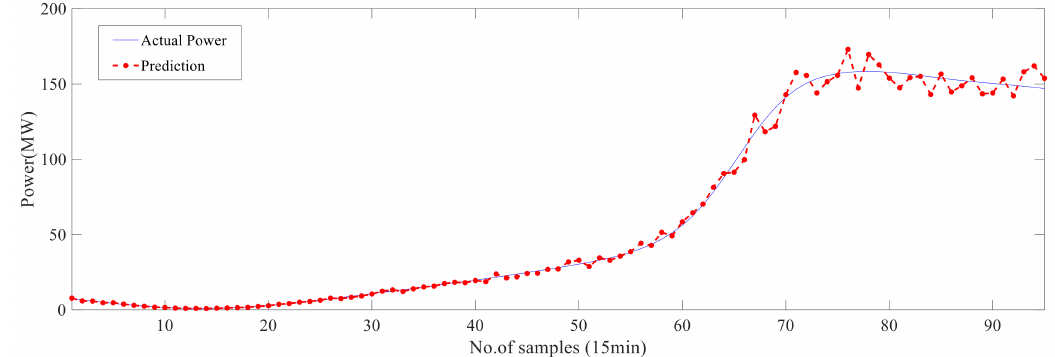
Figure 7. Actual and forecasted output power of wind plant for a summer day.